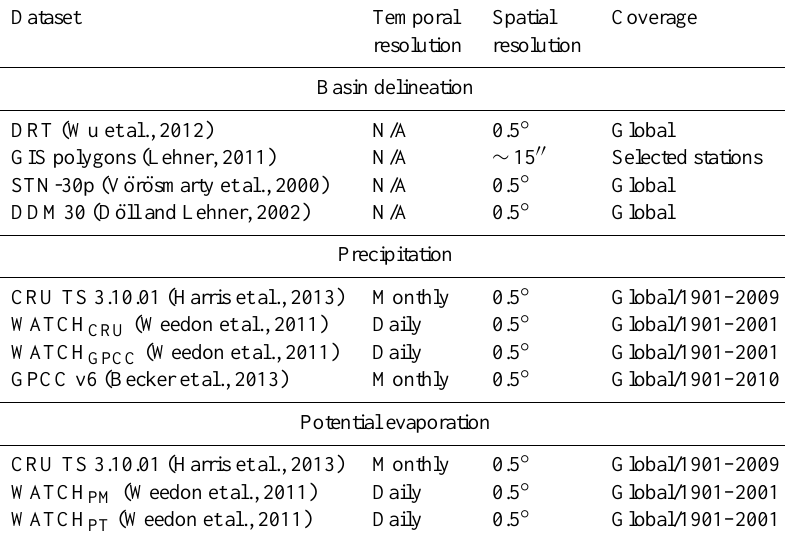
Table 1. Summary of global datasets used in the